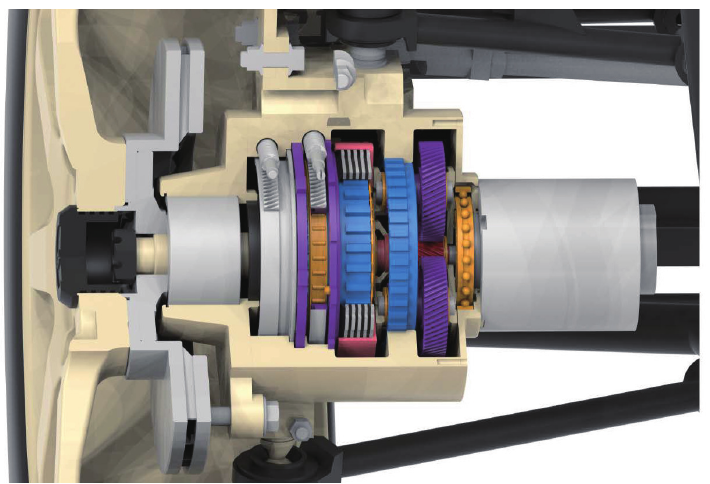
Figure 8. Structure of